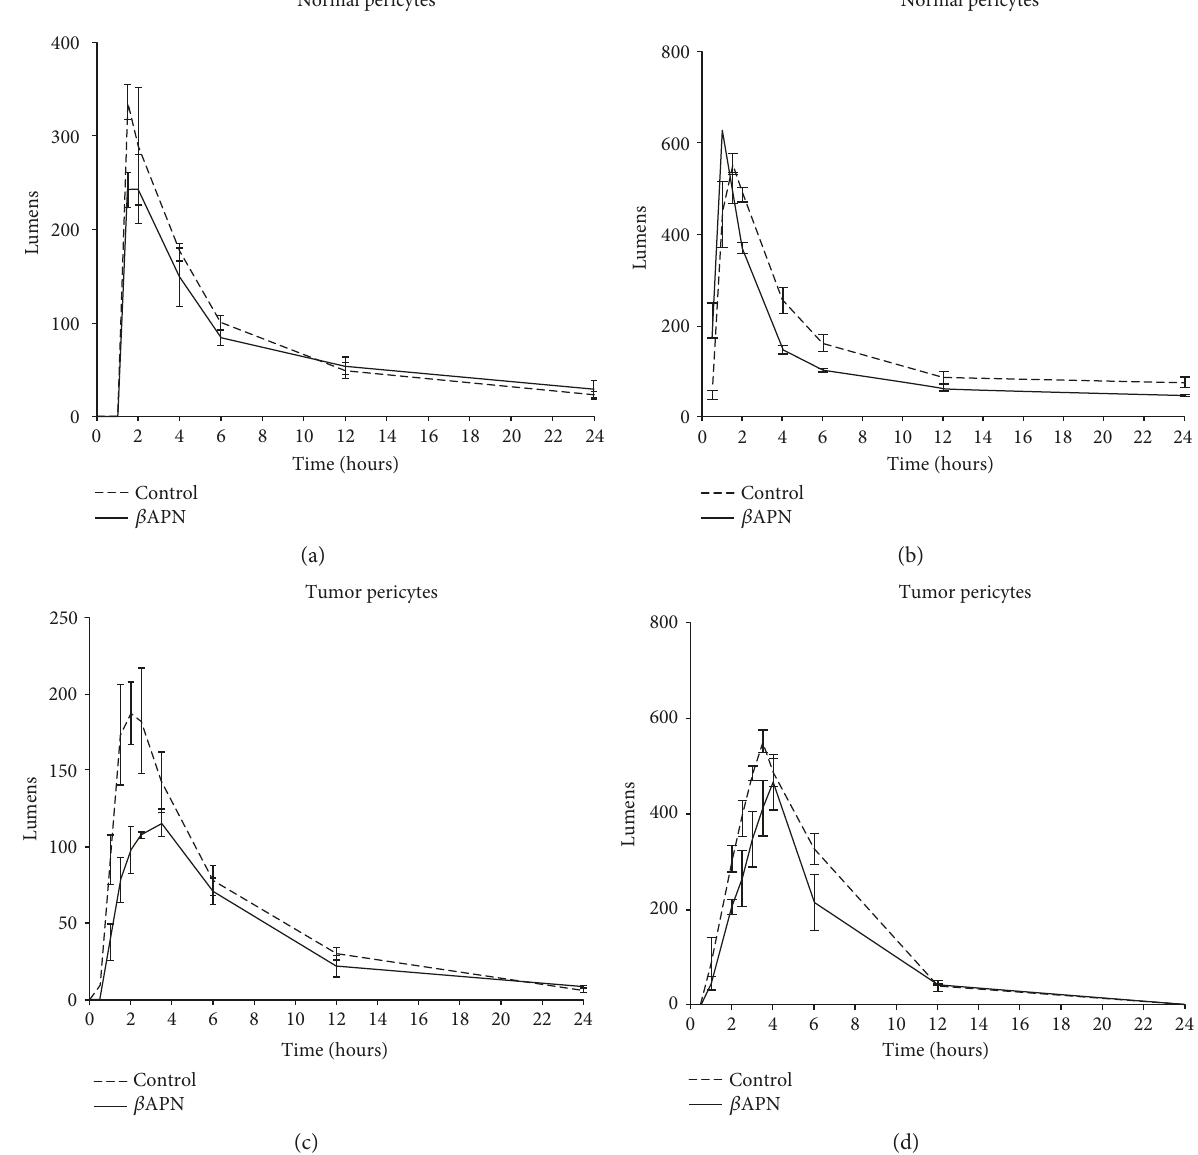
Figure 6: E ff ects of β APN on angiogenic properties of normal and tumor-associated pericytes. The kinetics of tube-like formation by pericytes was assessed for 24 hours under treatment with 1 μ M β APN in vitro. Normal pericyte samples: NP-Ad and NP-Mu. Tumor- associated pericyte samples: TP-Nbl and TP-Epn. (a) NP-Ad; (b) NP-Mu; (c) TP-Nbl; (d)